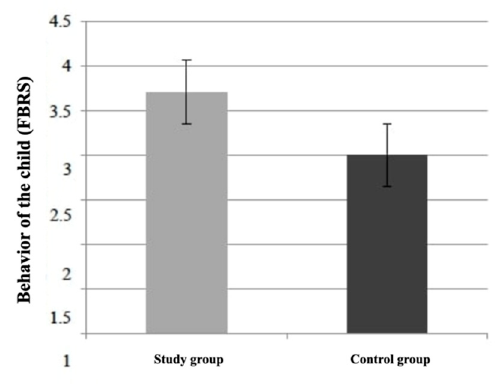
Figure 5. Dentists ‘evaluation of children’s Figure 5 . Dentists ‘evaluation of children’s behavior .